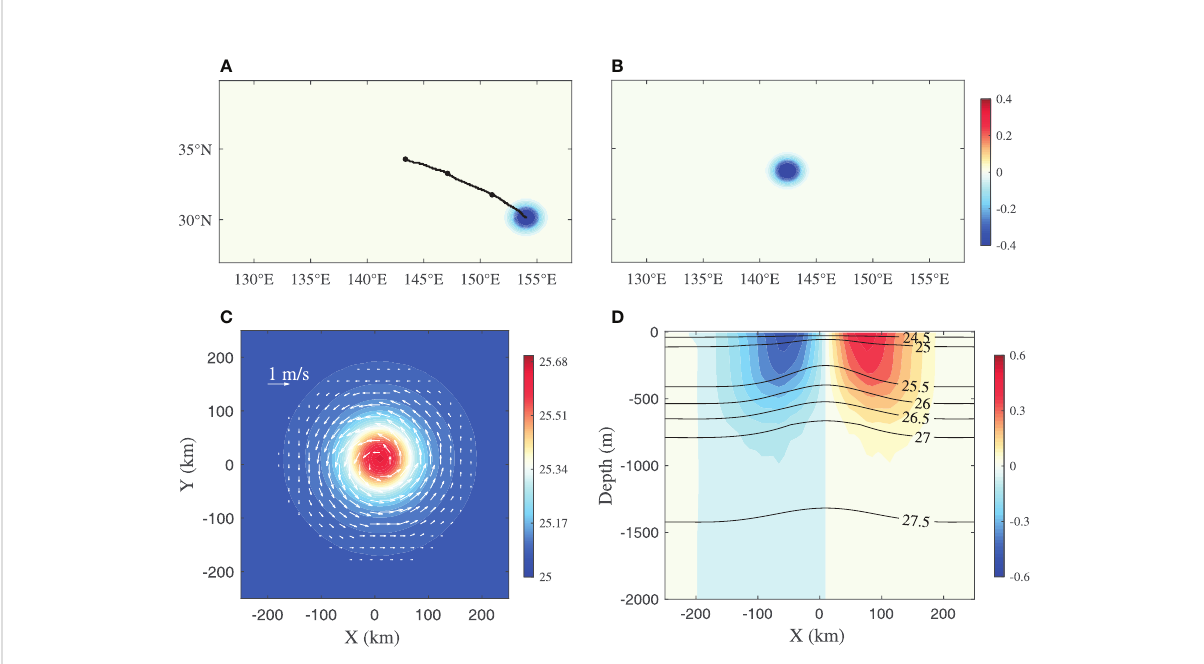
FIGURE 1 Tracks (black lines) of the idealized eddies on the (A) b -plane and (B) f -plane and the initial conditions of the idealized eddy, including (C) the potential density (shading) and horizontal velocity (vectors) at a depth of 200 m and (D) the vertical distribution of meridional velocity across the center of the eddy in the zonal direction. The color in (A) denotes the sea surface